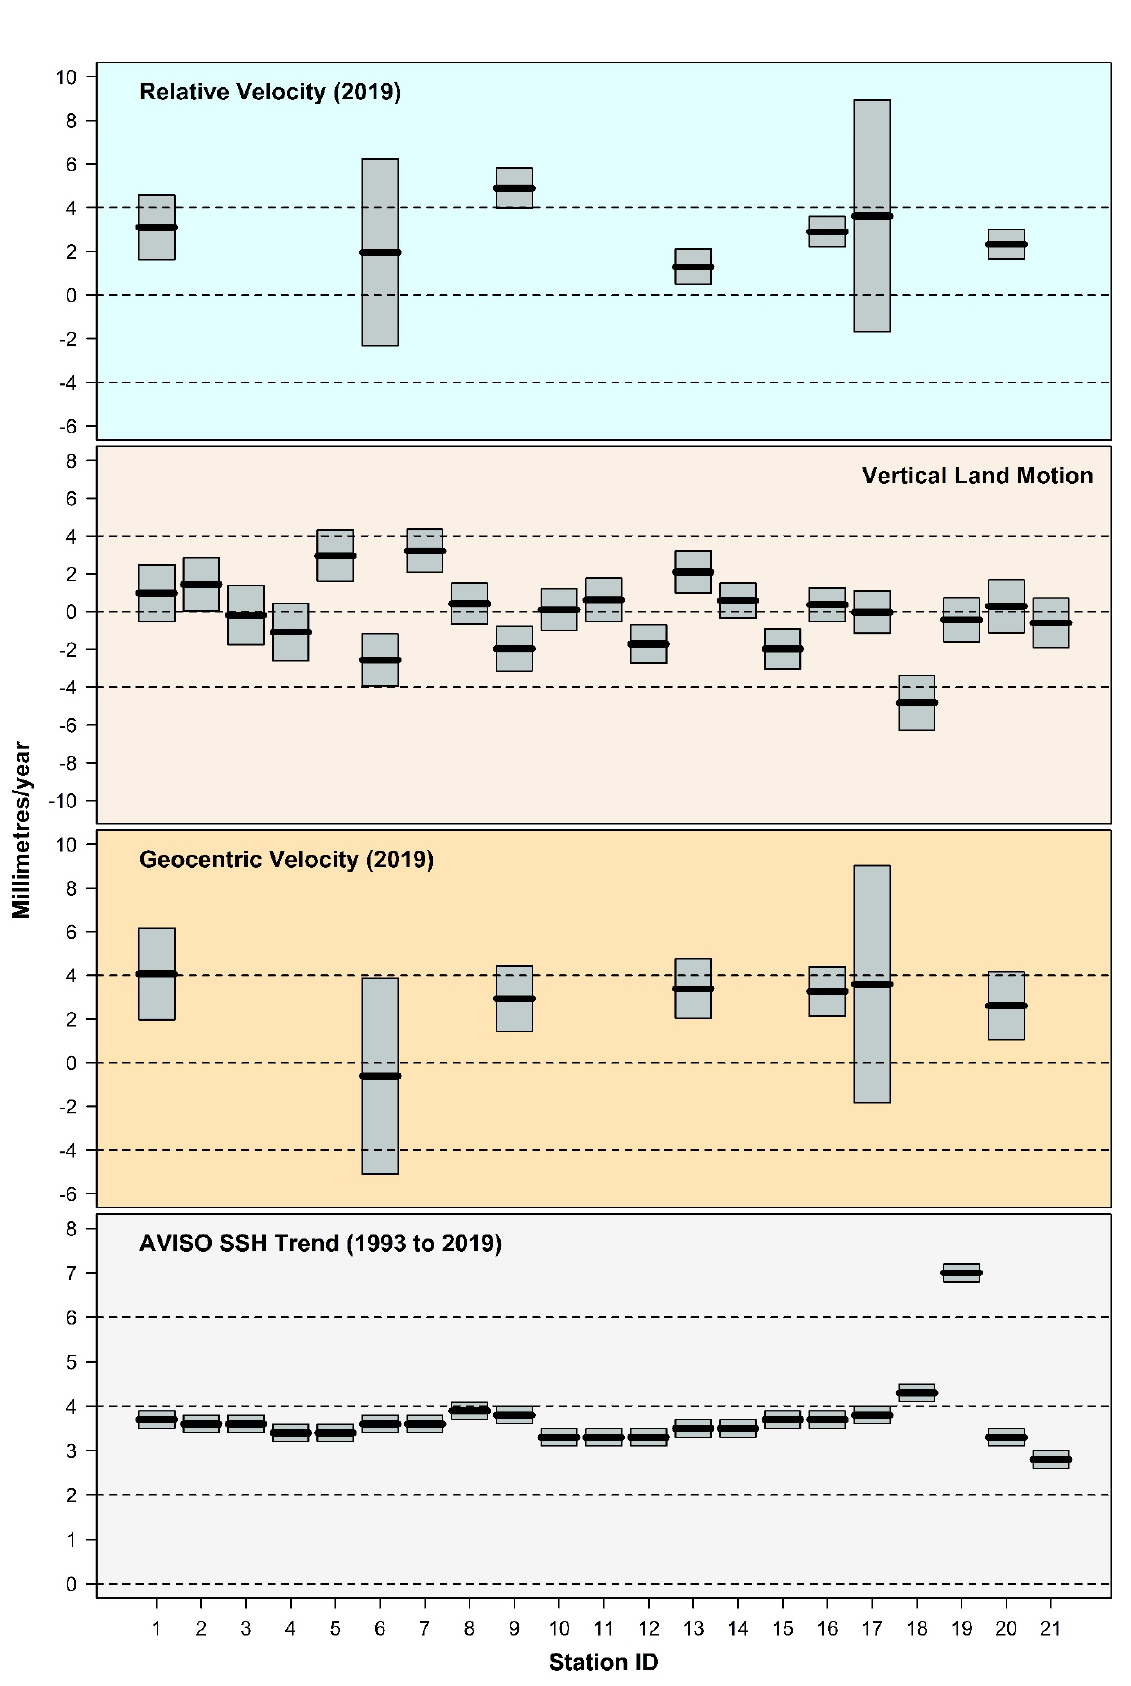
Figure 3. Summary of results. Only station records longer than 50 years have been used to determine “relative” and “geocentric” velocities in 2019. Refer to Figure 1 and Table 1 for station ID details. Shaded boxes represent 95% confidence intervals in each panel.